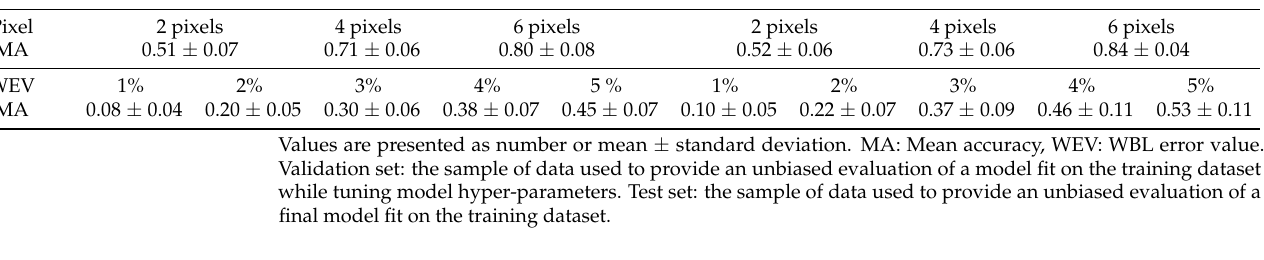
Table 2. Results regarding the prediction of the deep learning algorithm.